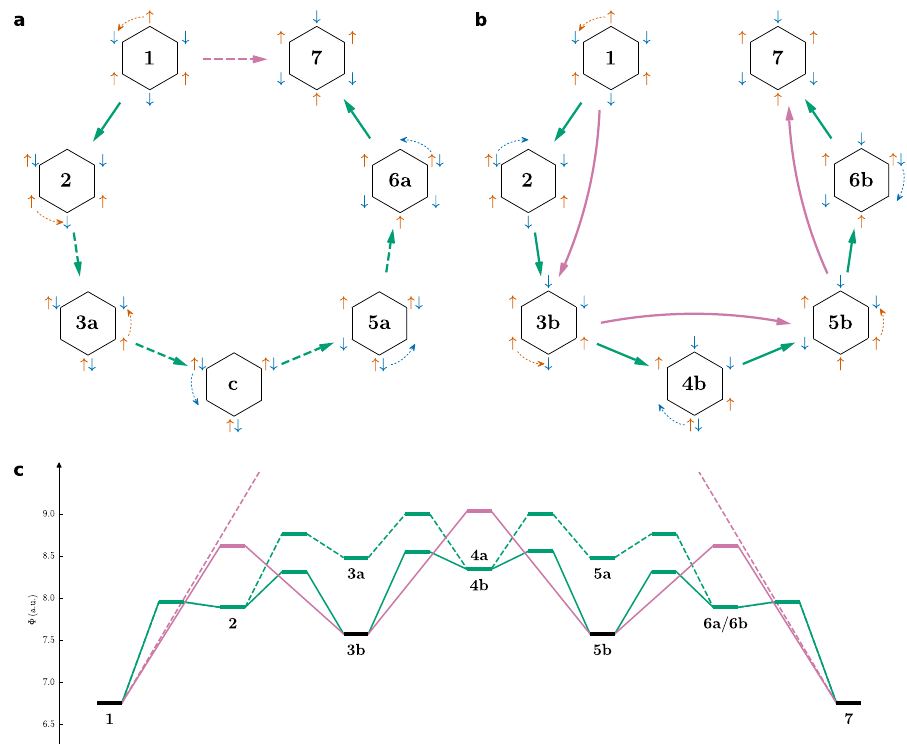
Fig. 5 Maximum probability paths for the π system of benzene. Without restrictions (green) and restricted to covalent DCPs (purple). Spin-up and spin- down electrons rotate in a the same direction, b opposite directions. c Probabilistic